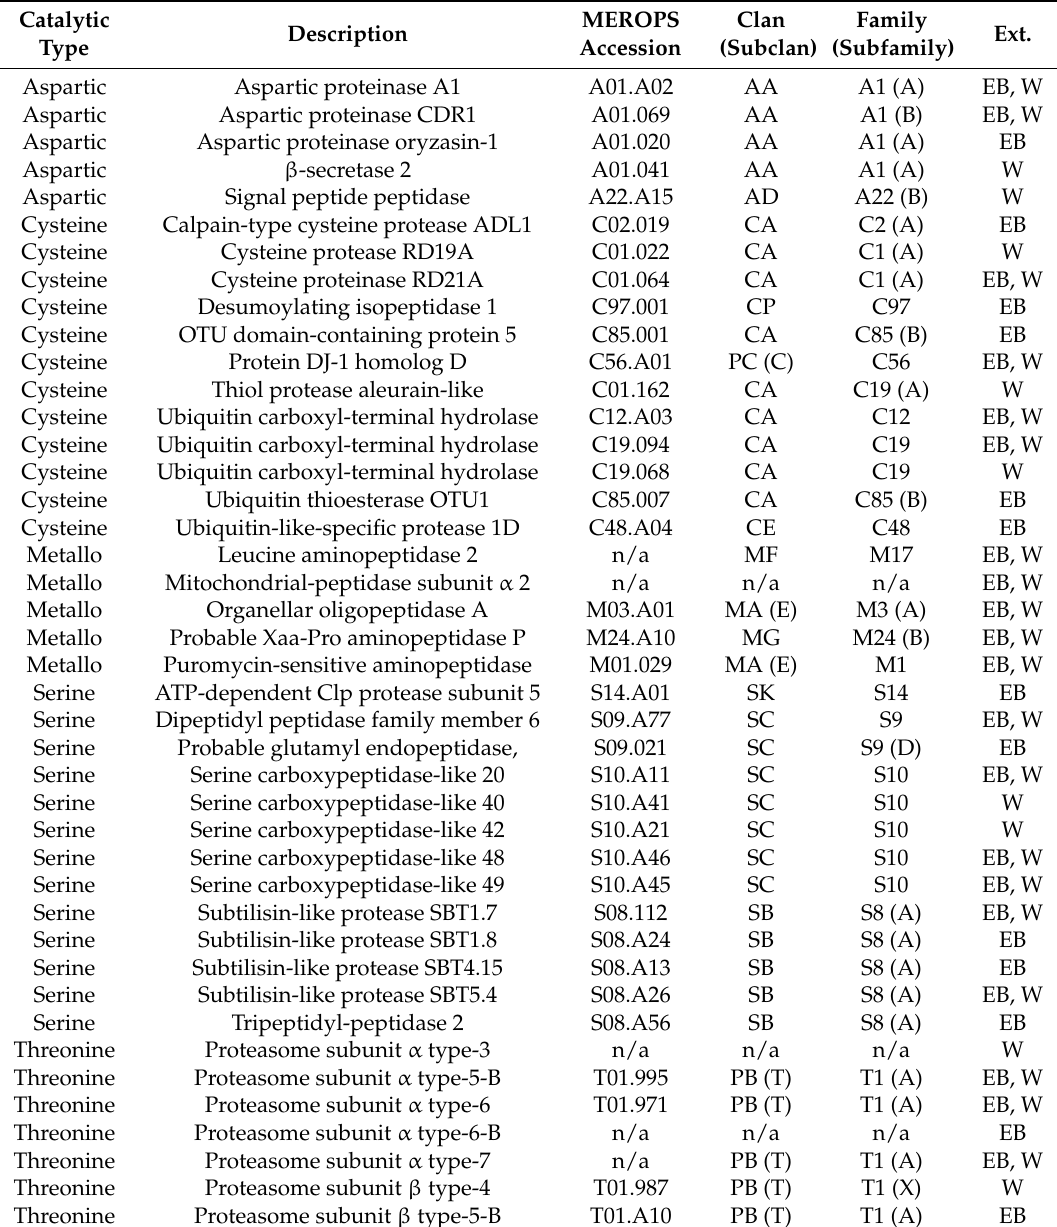
Table 1. Proteases identified via proteome and transcriptome cross-analysis of commercial birch pollen